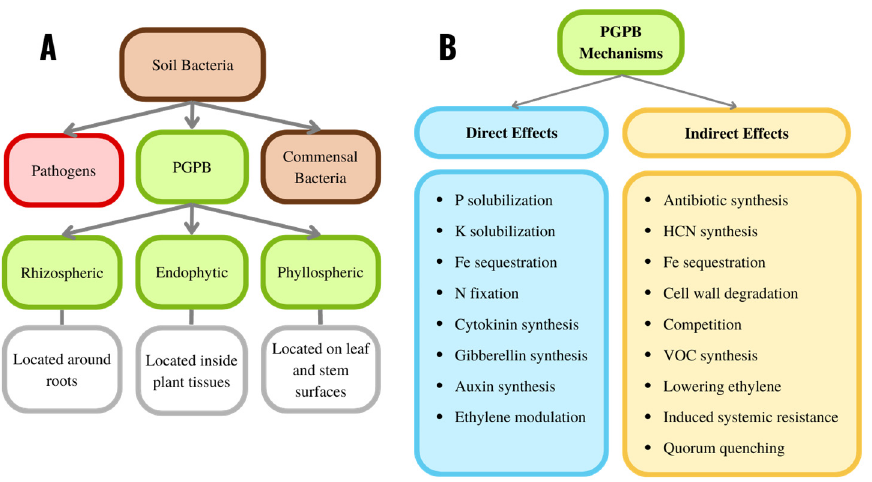
Figure 10. ( A ) Overview of some of the components of soil bacteria and their localization. ( B ) Overview of the major mechanisms used by PGPB. VOC refers to volatile organic compounds.